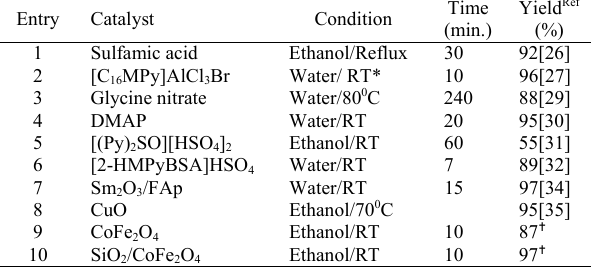
Table 4: Reaction of aldehyde and thiosemicarbazide using different catalysts Table 4. Reaction of aldehyde and thiosemicarbazide using different Entry